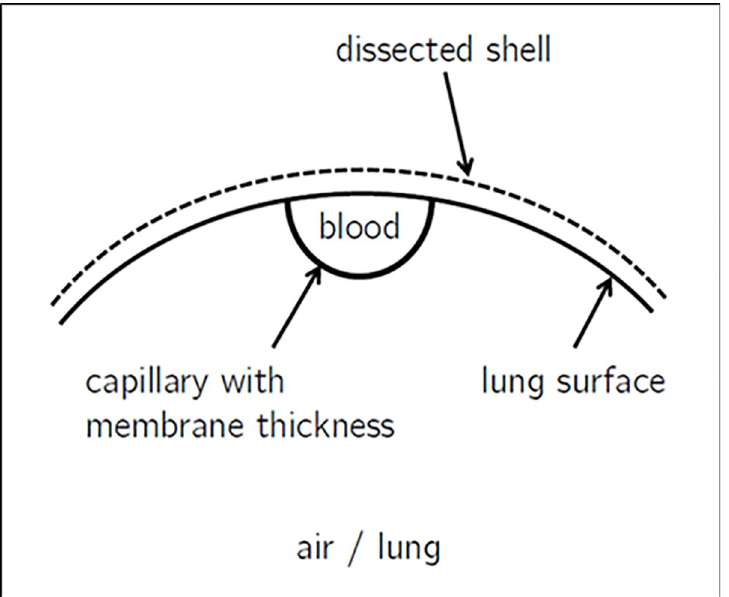
Fig 9. Geometrical shape of